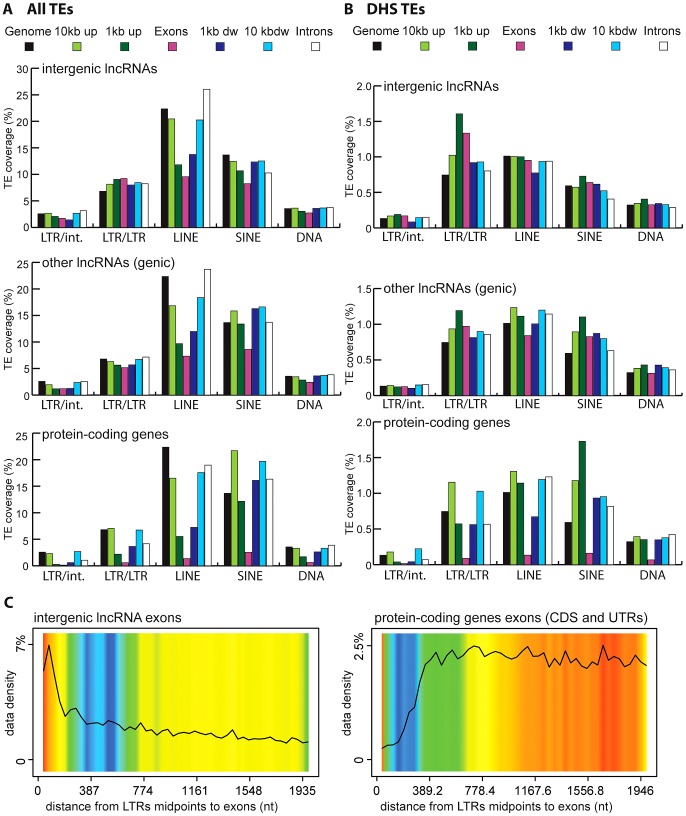
TE amounts and types in human lncRNA and their surrounding regions.Regions are genome, intergenic regions and exons. In the case of protein coding genes, exons include UTR exons as well as coding exons. 1 or 10 kb up and dw = intergenic regions up to 1 or 10 kb upstream of the TSS and downstream of the polyA respectively. Any annotated exons (RefSeq and Gencode v13 lncRNAs) have been subtracted from intergenic and intronic regions. A. Coverage of all TEs. LncRNA set corresponds to Gencode v13, separated in lincRNA transcripts (intergenic) and genic transcripts. Coverage is calculated as described for Figure 2 and in Methods and is shown per TE class (LTR/ERV, nonLTR/LINE, nonLTR/SINE, DNA) with an additional separation between ERVs (LTR/LTR) and internal parts (LTR/int) of ERV elements. B. Same as A, except that only TEs that overlap with DNaseI hypersensitive sites (‘TE-DHS’) are considered (see Methods). C. Heatmap of distance between LTR and lincRNA (left) and protein-coding genes (right) aggregated for all chromosomes (Jaccard test see Methods). The x-axis is the alignment of all reference features (protein coding exons and lncRNAs). The line depicts the total percentage of TEs found along the reference feature. The color quantifies the departure from null distribution generated from permutation. “Hot” (red) and “cool” (blue) colors mean that there was more or less TEs observed at a given position than by chance, respectively. All p–value <0.001.